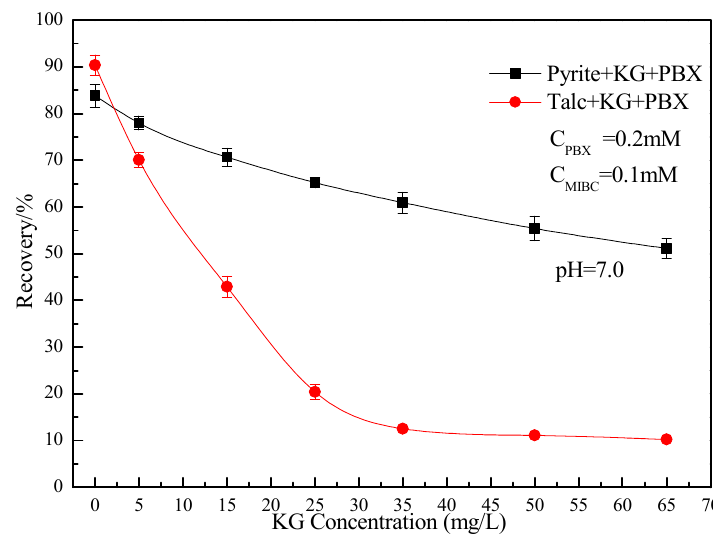
Figure 5. Effect of konjac gum (KG) concentration on the microflotation recovery of pyrite and talc.